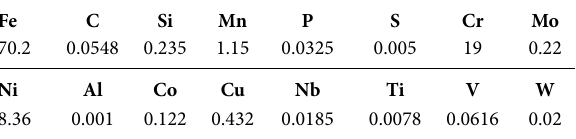
Table 1. Chemical composition of raw workpiece (wt. %).